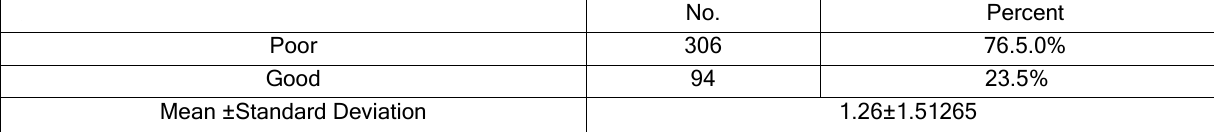
Table 7: frequency of practice score among the